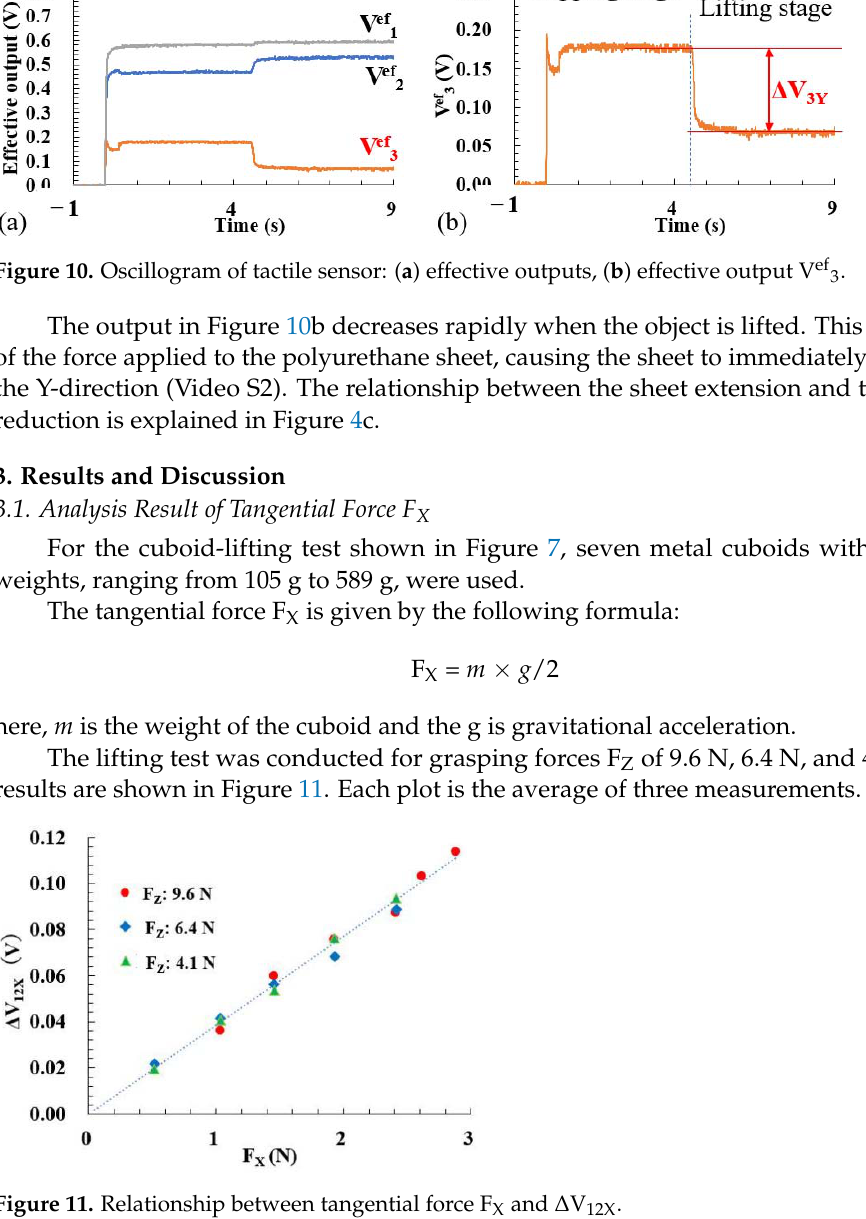
Figure 11. Relationship between tangential force F X and Δ V 12X .